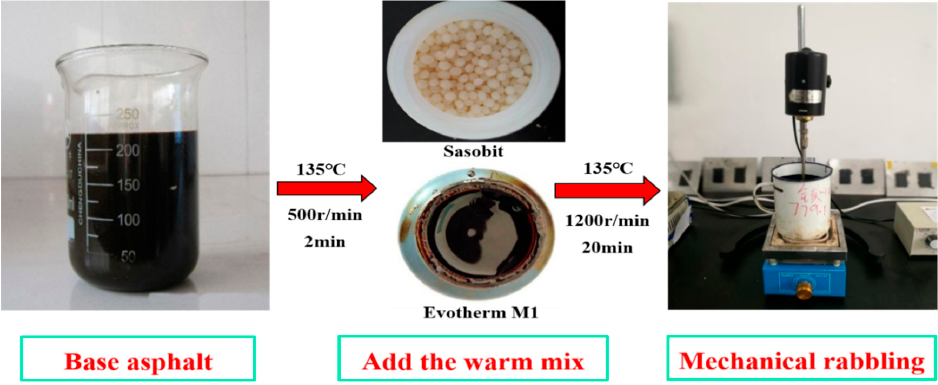
Figure 1. Flow chart of warm mix asphalt (WMA) preparation.